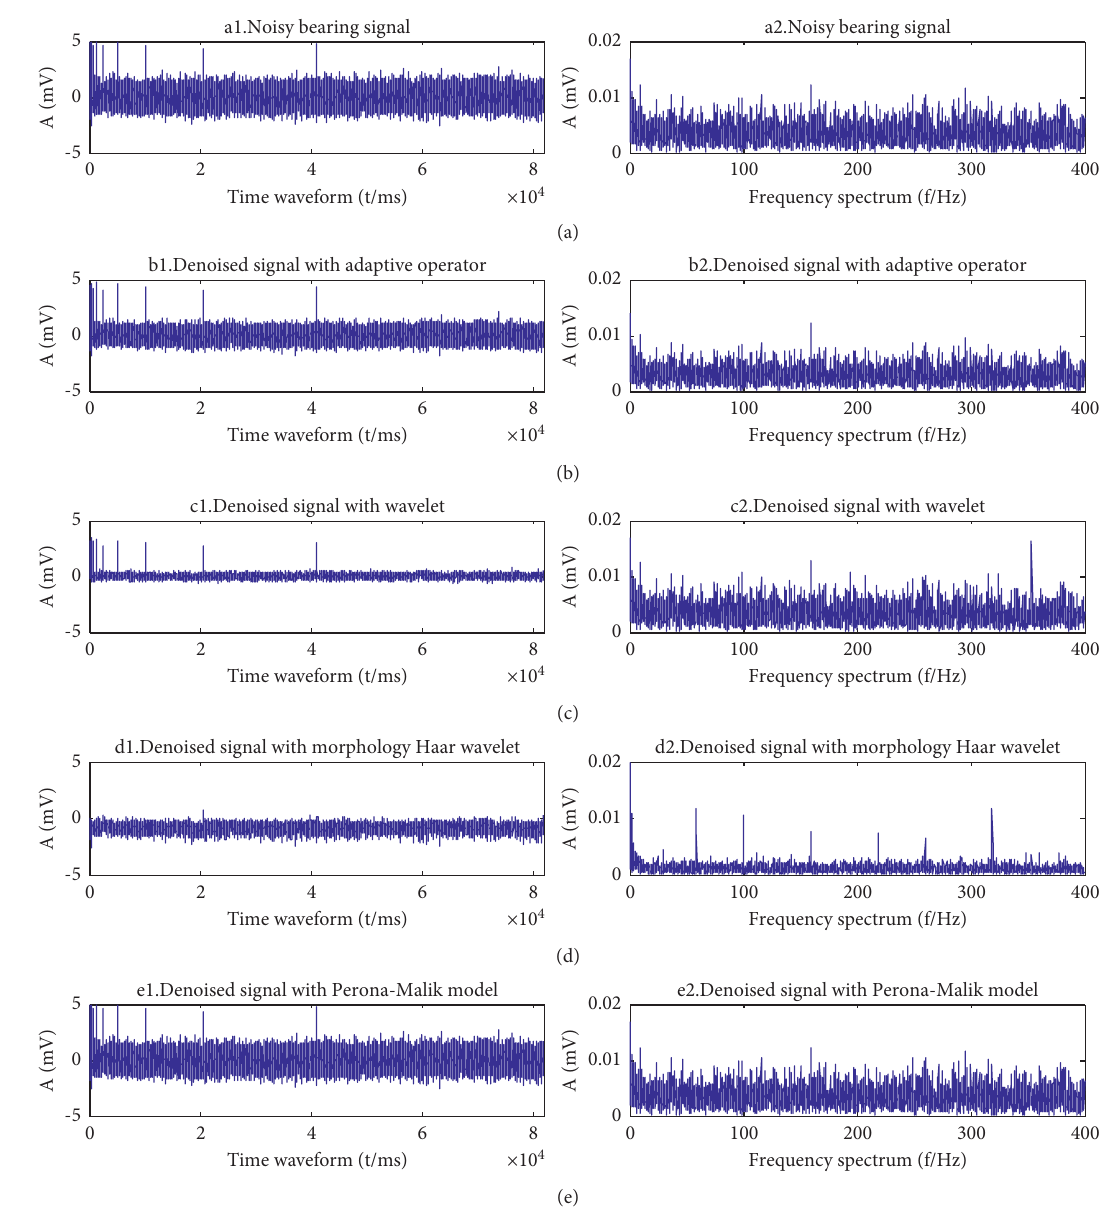
Figure 6: CWRU measured data. (a) Noisy bearing signal. (b) Denoised signal with adaptive operator. (c) Denoised signal with wavelet. (d) Denoised signal with morphology Haar wavelet. (e) Denoised signal with Perona–Malik